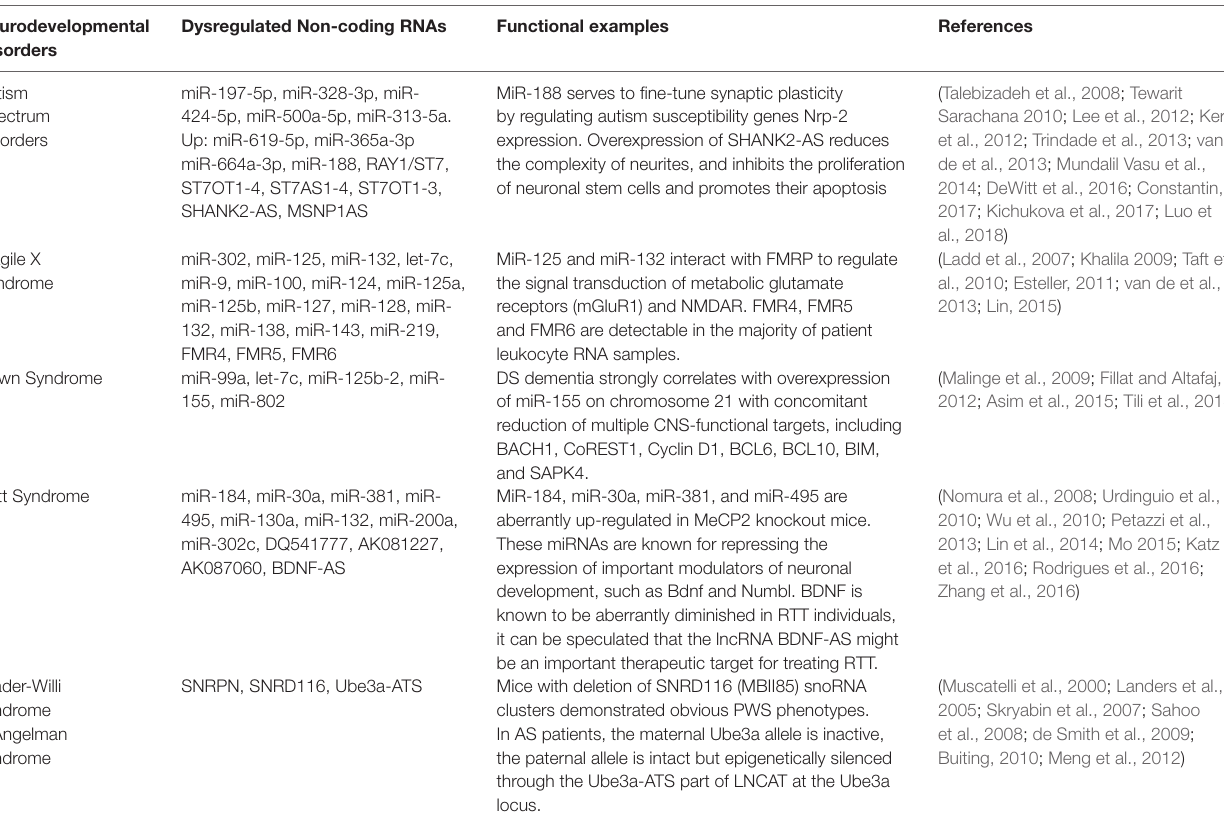
TABLE 1 | Non-coding RNAs are related to neurodevelopmental